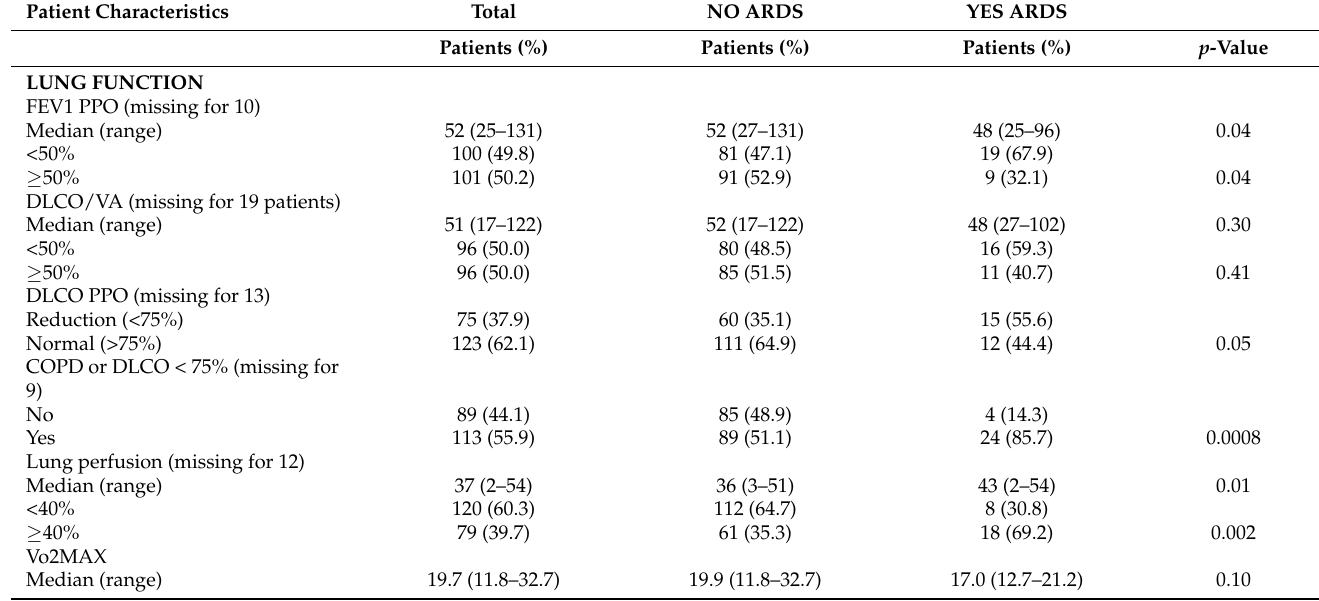
Table 2. Functional, morphometric and biologic factors associated with development of